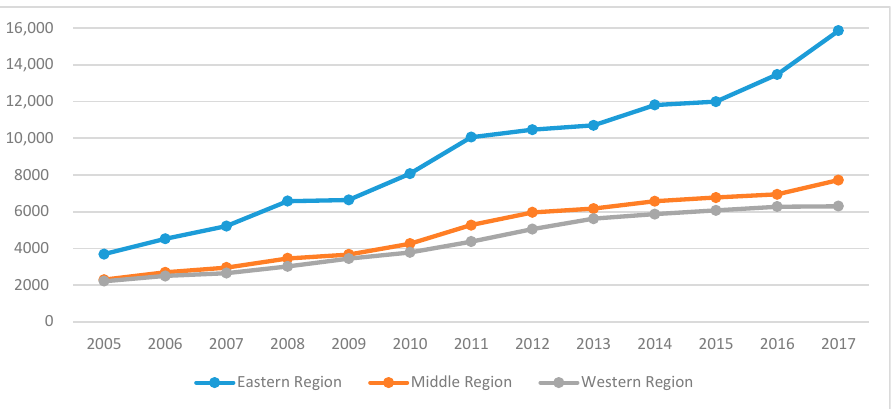
Figure 3. The average real estate price of the large and medium-sized cities in the eastern, middle and western regions of China (Unit: RMB/sq. m.). Source: arranged by the authors.